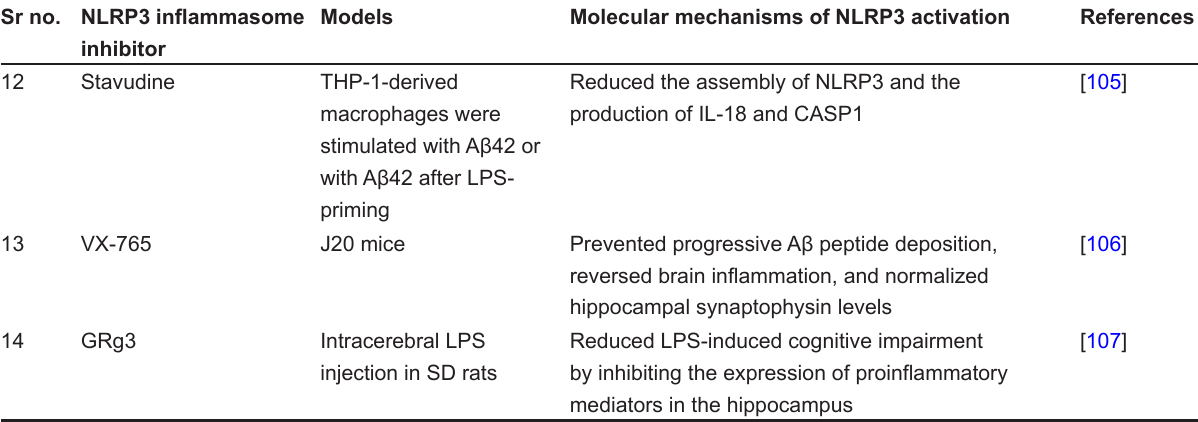
Table 1. The underlying mechanism of several NLRP3 inflammasome inhibitors ( continued ) Sr no. NLRP3